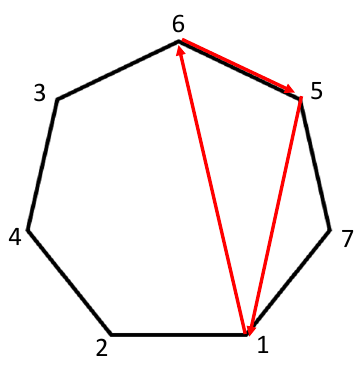
Figure 19 . The clockwise oriented heptagon for Gunaydin-Gursey octonions. The order is in agreement with P GG = (1243657) . The first triad 123 is shown by red arrows. The second will be 257 as we can see from the figure, etc.